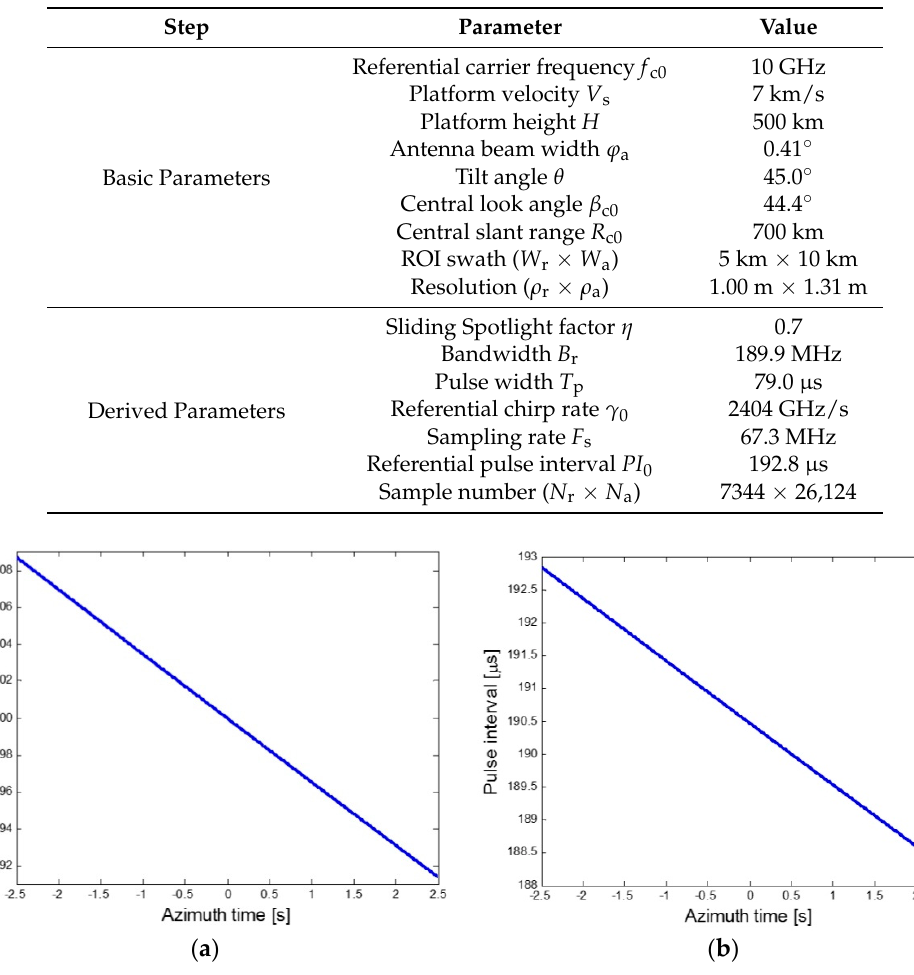
Figure 9. Variations of: ( a ) CBSR; and ( b ) PI array with respect the azimuth time.